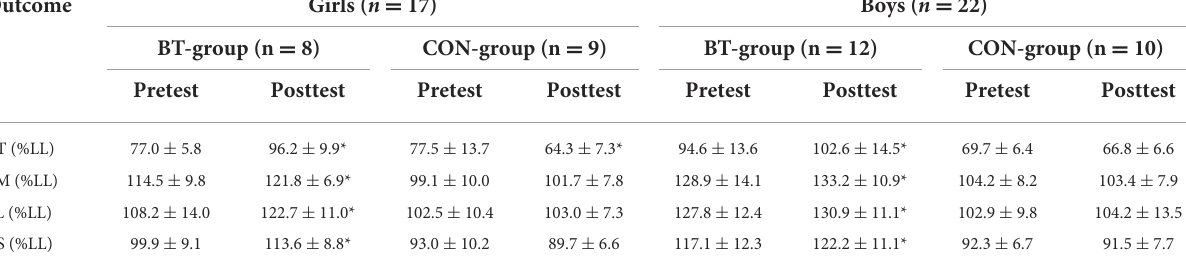
TABLE 2 Performance changes from the pretest to the posttest per outcome measure. Outcome